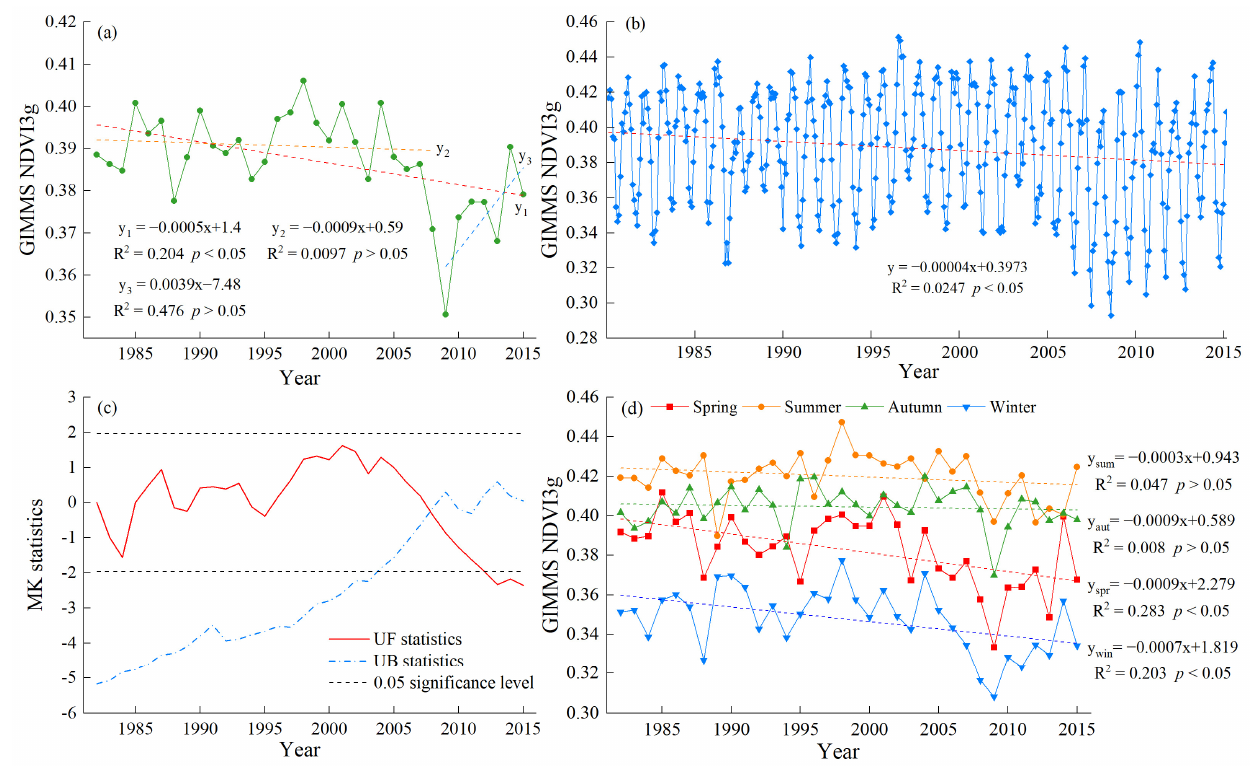
Figure 3. ( a ) Annual NDVI time series in Argentina from 1982 to 2015. ( b ) Monthly NDVI time series in Argentina from 1982 to 2015. ( c ) Mann–Kendall (M-K) test of the NDVI in Argentina from 1982 to 2015. ( d ) Seasonal NDVI time series in Argentina from 1982 to 2015. Based on the least squares method, according to Formula (2), the changing trend of NDVI in Argentina over the past 34 years was calculated with time as the independent